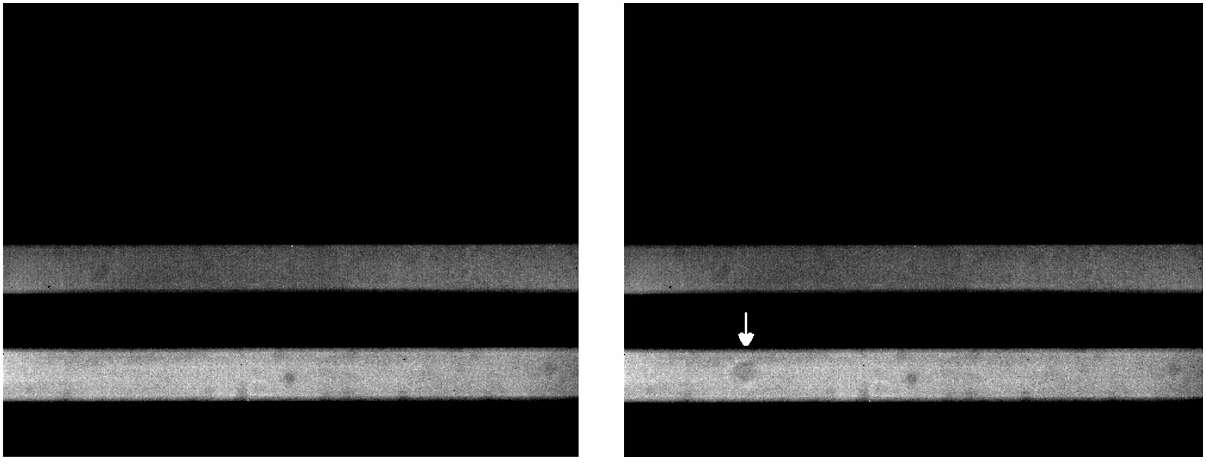
Figure 9. Diagnostic readout of SCA-A from pre-flight ( left ) and on-orbit ( right ). Each image contains the 640 columns of the detectors for the array. The upper bright band is the detectors illuminated by the Band 10 spectral filter, while the lower bright band is the detectors illuminated by the Band 11 spectral filter. The dark areas are detectors that are masked out and do not receive light from the telescope. The arrow indicates the area of contamination on the Band 11 filter that appeared after